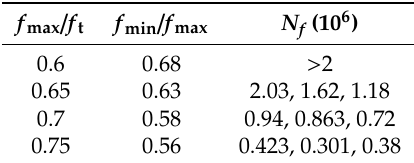
Table 9. Relationship between the maximum tensile stress under dynamic load ( f max ) / f t and fatigue life ( N f ) from the fatigue test.